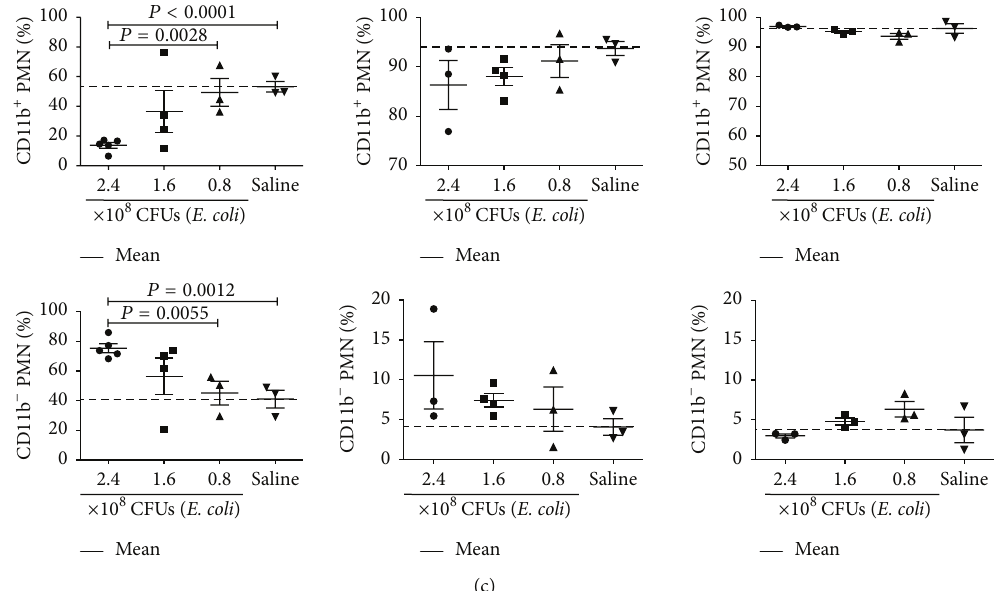
Figure 3: The numbers of PLCs and PMNs in mice infected intraperitoneally with E. coli . ICR mice were infected intraperitoneally with 3 doses of E. coli or received saline and sacrificed at 18, 48, and 72 hours to harvest their PLCs. The PLCs were counted immediately or stained with fluorescence-labeled mAbs of anti-CD45 and anti-CD11b followed by numerating with flow cytometry. (a) Numbers of PLCs. (b) Ratios of PMNs in PLCs. (c) Ratios of CD11b + PMNs and CD11b − PMNs in the PMNs. Each point represents the data from one mouse.